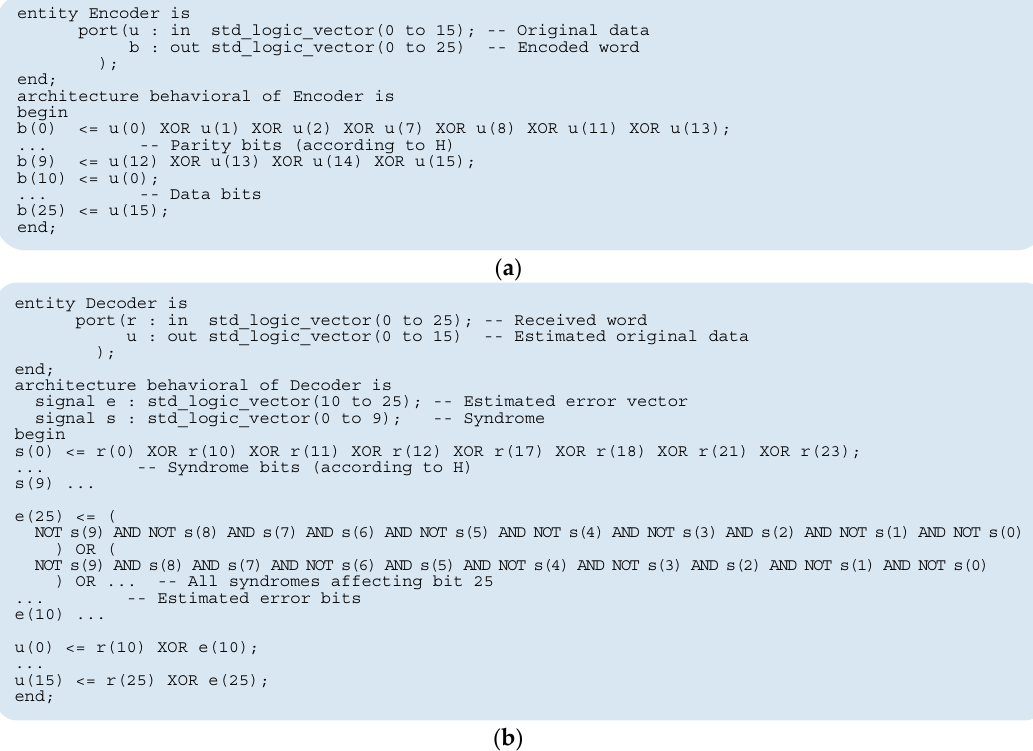
Figure 6. Excerpt of the VHDL implementation for the (26, 16) low redundancy and reduced overhead (LRRO) double error correction (DEC) code: ( a ) encoder and ( b ) decoder.